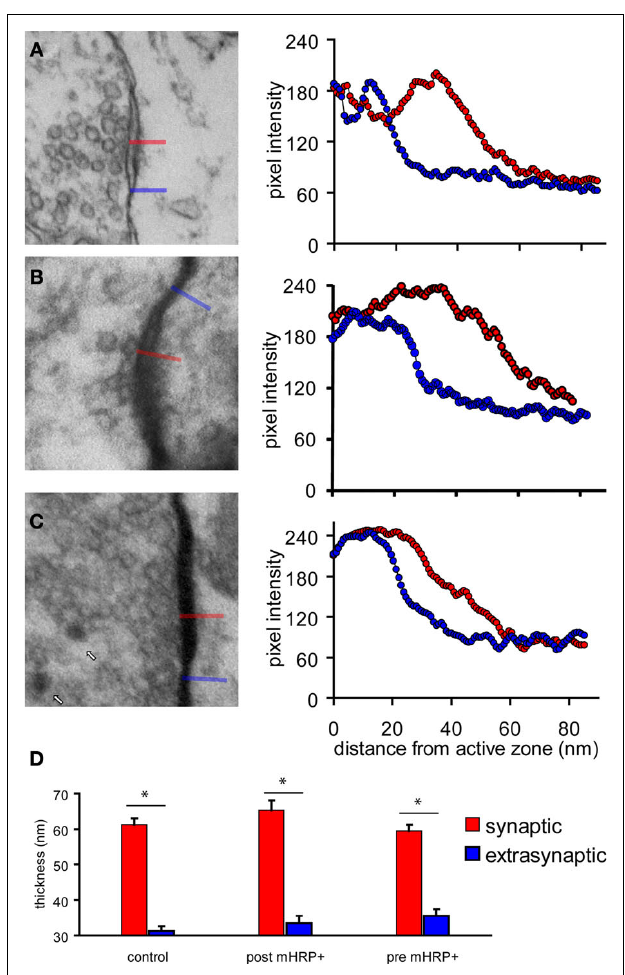
FIGURE 6 | Criteria to identify synaptic contacts. (A–C) Electron micrographs on the left show synaptic contact in control tissue (A) , synapse with postsynaptic profi les labeled by mHRP (B) , synapse with presynaptic profi les labeled by mHRP (C) . Synapses are identifi ed according to the presence of clustered synaptic vesicles opposed to the membrane of one profi le in at least two serial sections. Measurements of pixel intensities taken from the locations of the red and blue lines, which mark synaptic and extrasynaptic sites (histograms on right of each image) provide an independent means to identify synaptic sites. Note that the thickness of the electron dense membrane and cleft is consistently greater at synaptic sites than at extrasynaptic sites. The average thickness at extrasynaptic sites in the pre mHRP + samples is signifi cantly greater than controls ( p < 0.05), likely due to distribution of DAB label. White arrows in (C) mark recycled synaptic vesicles labeled by mHRP (see text for details). (D) The thickness at synaptic and extrasynaptic sites analyzed from tissues represented in panels (A–C) . * p <